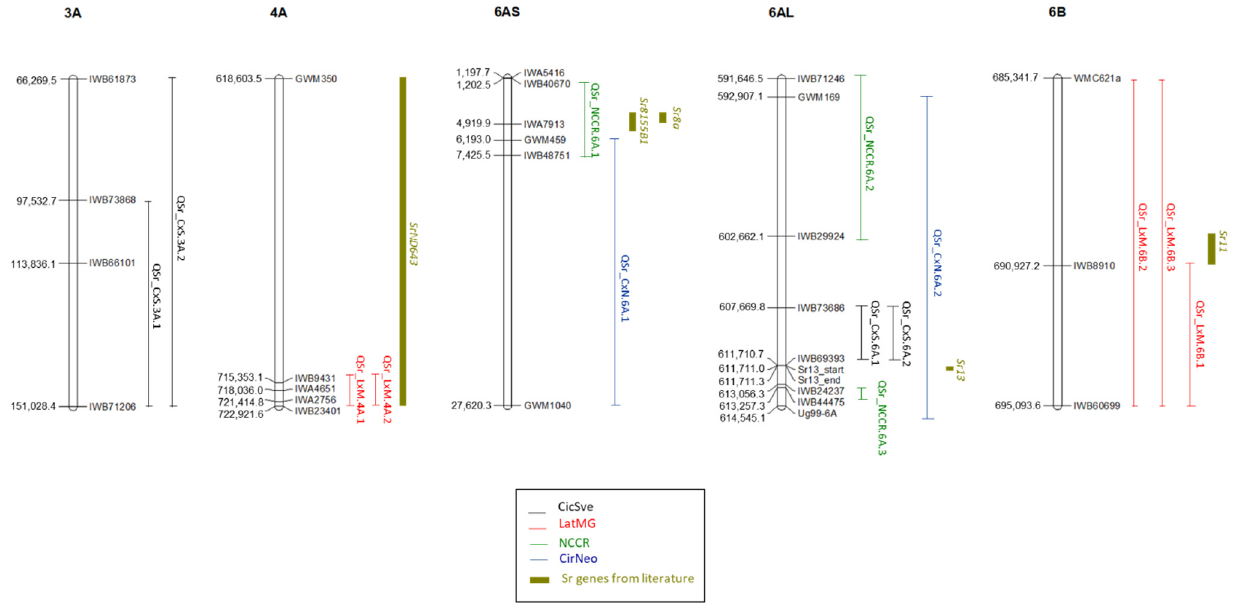
Figure 2. Physical map position of the QTLs identified in the present study and of the known resistance genes mapped to the same regions.